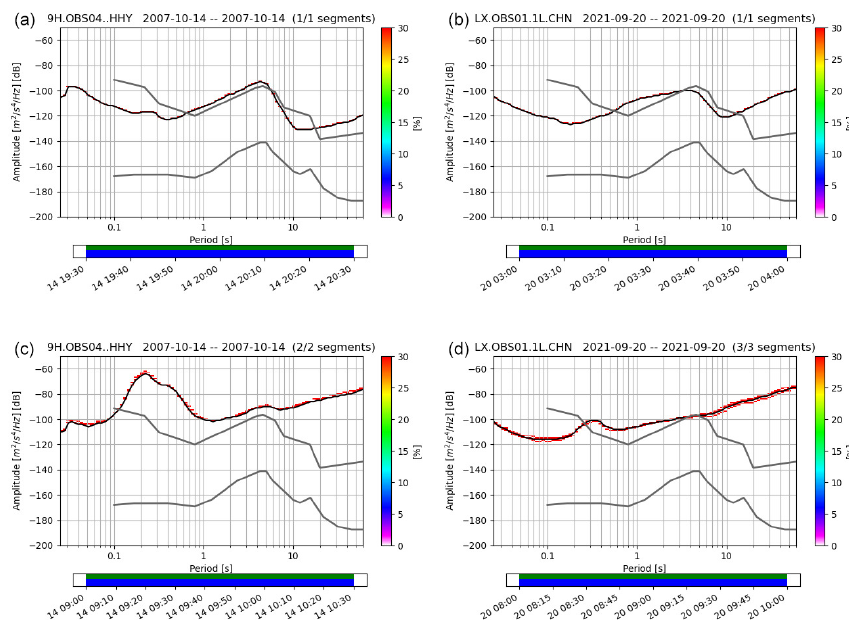
Figure 13. PPSD of 9H OBS04 and LX OBS01 during laminar and turbulent flow events – different high current flow speed scenarios on 14 October 2007 (9H OBS04) and 20 September 2021 (LX OBS01). The upper part of the figure represents the laminar flow scenario in both OBSs, and the bottom part is the turbulent one.